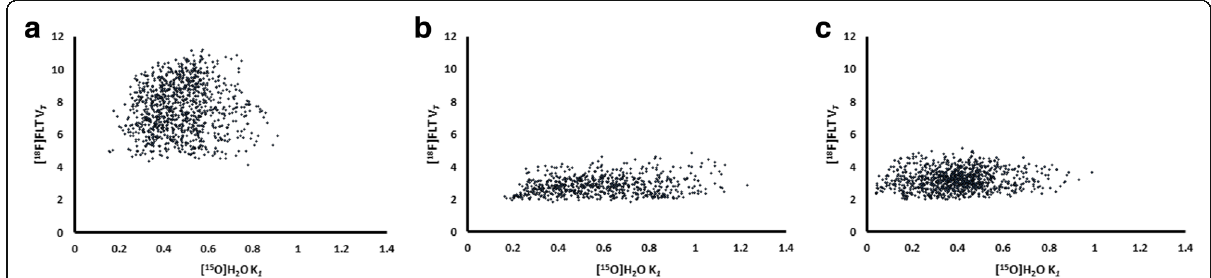
Fig. 2 Scatterplots of voxelwise association between TBF and [ 18 F]FLT V T for the tumour VOI for one patient at the three different time points: baseline ( a ), 7 days post-therapy ( b ) and 28 days post-therapy ( c